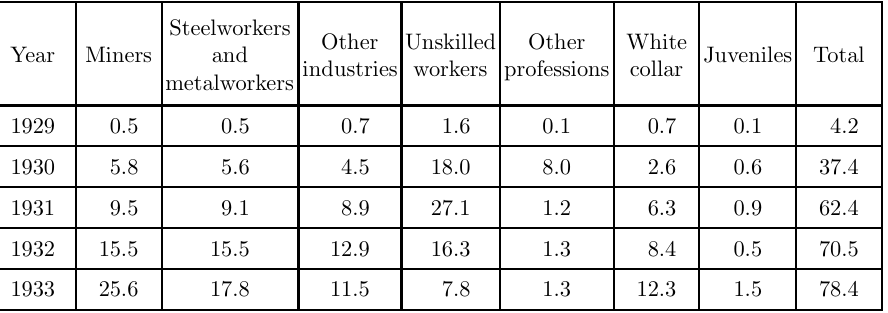
The number of unemployed people in Upper Silesia in 1929–1933 (in thousand